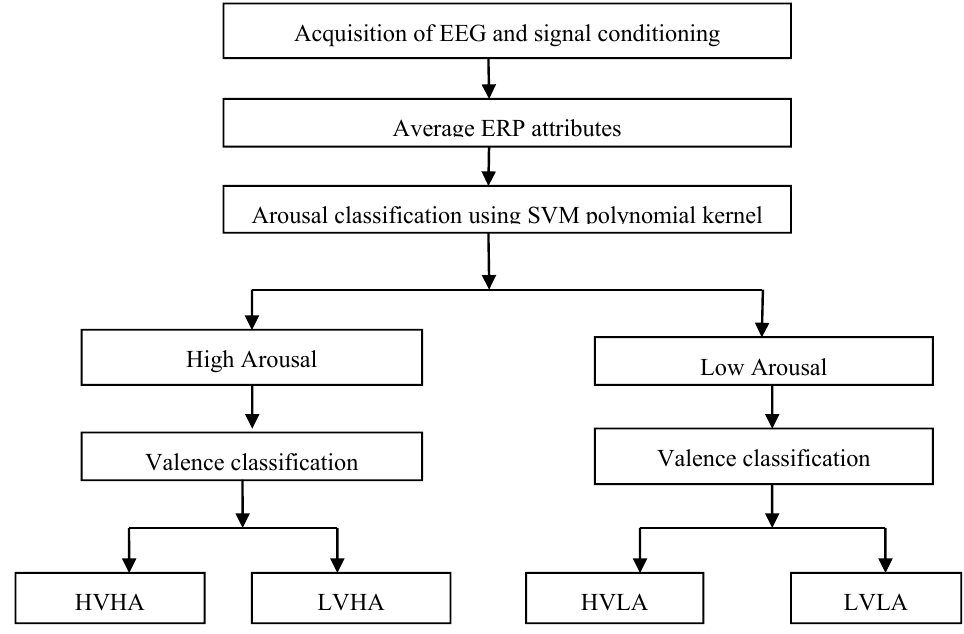
Figure 5. A flowchart of the three ‐ classifier methodology used for classification of emotions.